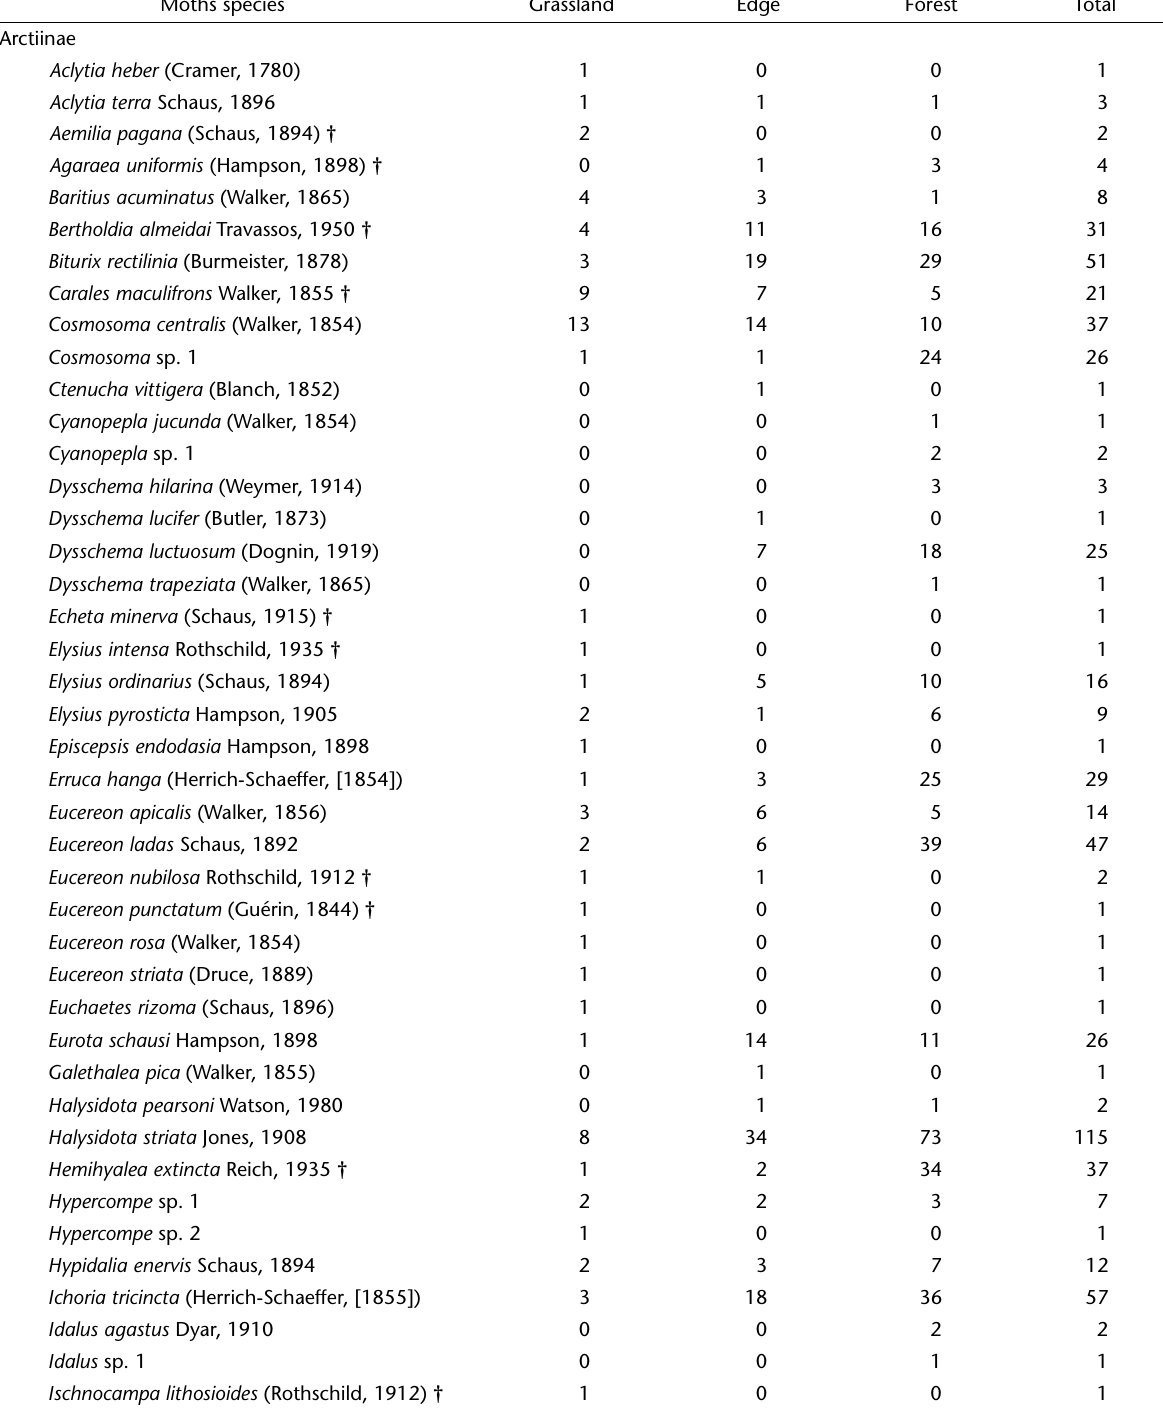
Table II. List of tiger moths of São José dos Ausentes and their abundance in the three habitats. Moths species Grassland Edge Forest Total